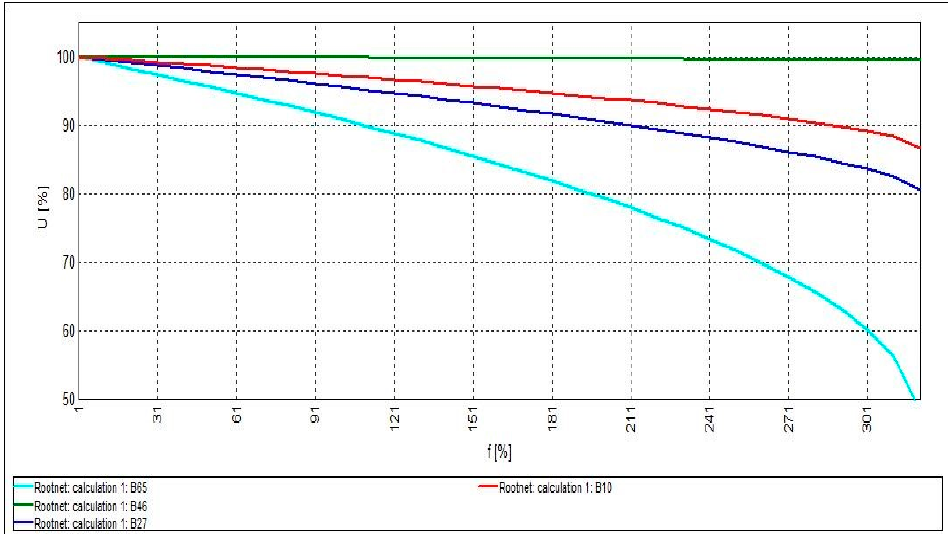
Figure 3. PV curves of the IEEE 69 ‐ node RDS system in its original case.